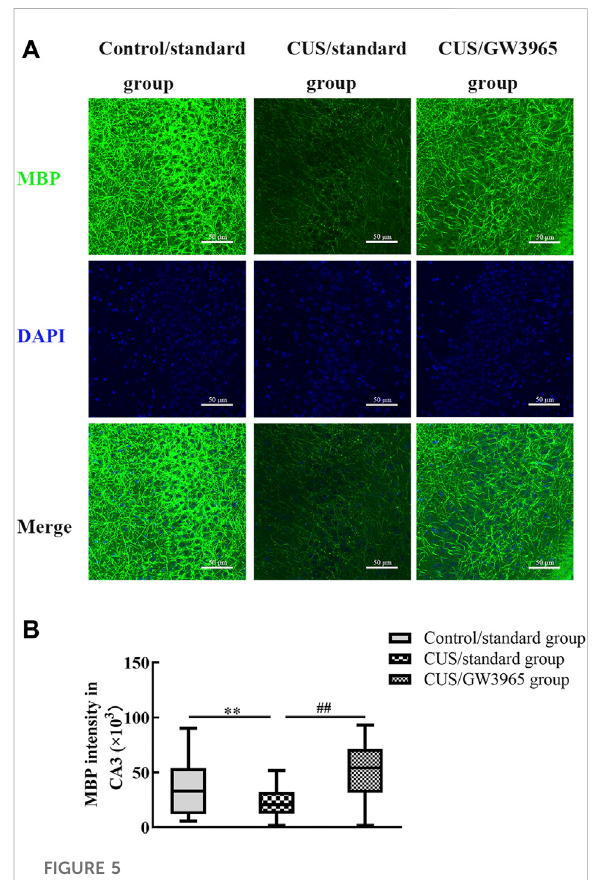
FIGURE 5 Illustration of the MBP staining intensity. (A) Representative images of immuno fl uorescence staining of MBP in the CA3 subregion in the three groups. MBP: green, DAPI: blue. Bar = 50 μ m. (B) Comparisons of the MBP staining intensities in differentsubregionsof thehippocampus among thethree groups. pp indicates p < 0.05 for the CUS/standard group compared with the Control/standard group. ## indicates p < 0.05 for the CUS/ standard group compared with the CUS/GW3965 group. All the data are shown as the upper and lower